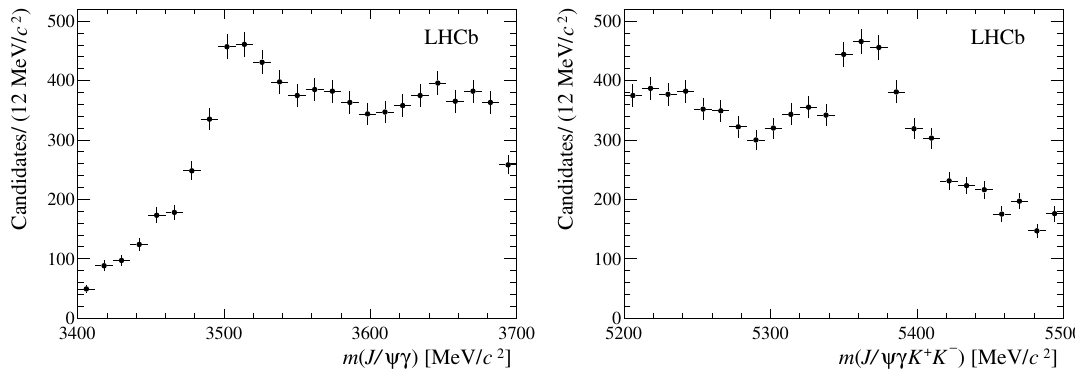
Figure 2 . Invariant-mass distributions of (left) J= (cid:13) and (right) J= (cid:13)K + K selection